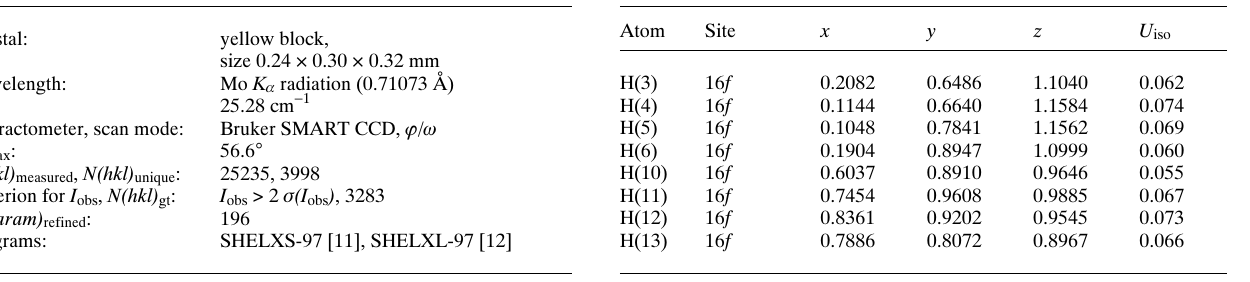
Table 2. Atomic coordinates and displacement parameters (in Å 2 ) . Table 1. Datacollection and